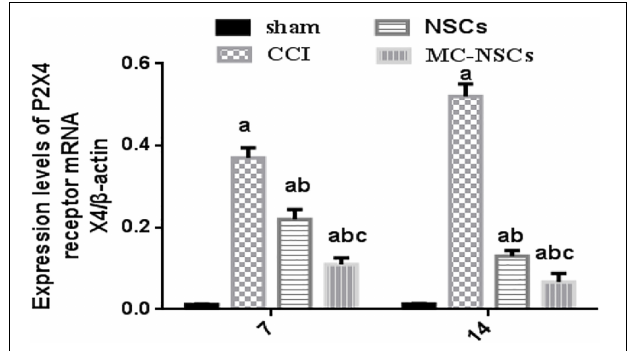
FIGURE 6 | Results of P2 × 4R mRNA expression in the L4–5 spinal cord by using RT-qPCR. The expression level of P2 × 4R mRNA from high to low was found in the CCI, NSC, MC-NSC, and sham groups. Data were expressed as the mean ± SD of three replicates ( n = 6). a p < 0.05 vs. sham group; b p < 0.05 vs. CCI group; c p < 0.05 vs. NSC